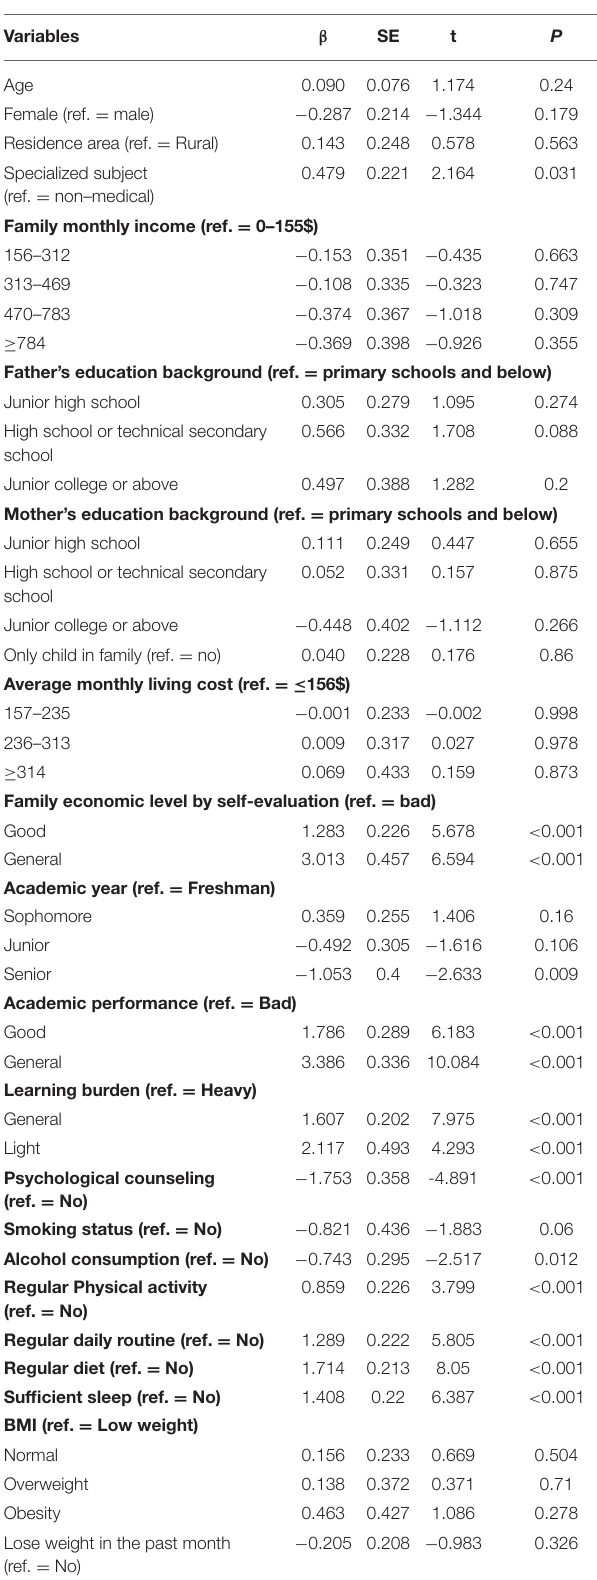
TABLE 4 | Multiple linear regression of satisfaction with life of college